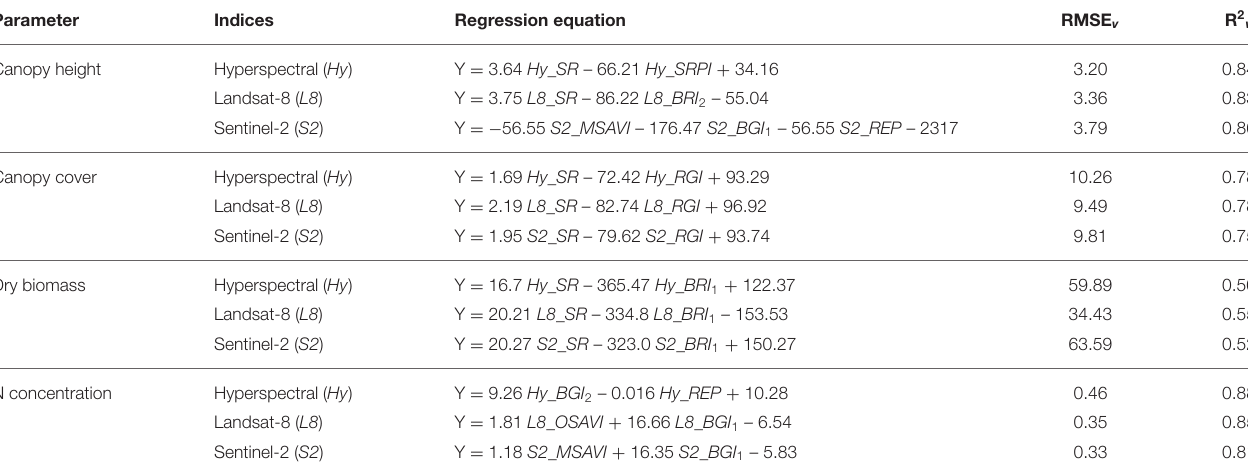
TABLE 5 | Validation statistics (RMSE v and R 2 v ) of multilinear regression models of Hyperspectral ( Hy ) indices, and synthesized Landsat-8 ( L8 ) and Sentinel-2 ( S2 ) indices obtained for canopy height, canopy cover, dry biomass and nitrogen (N) concentration of finger millet.